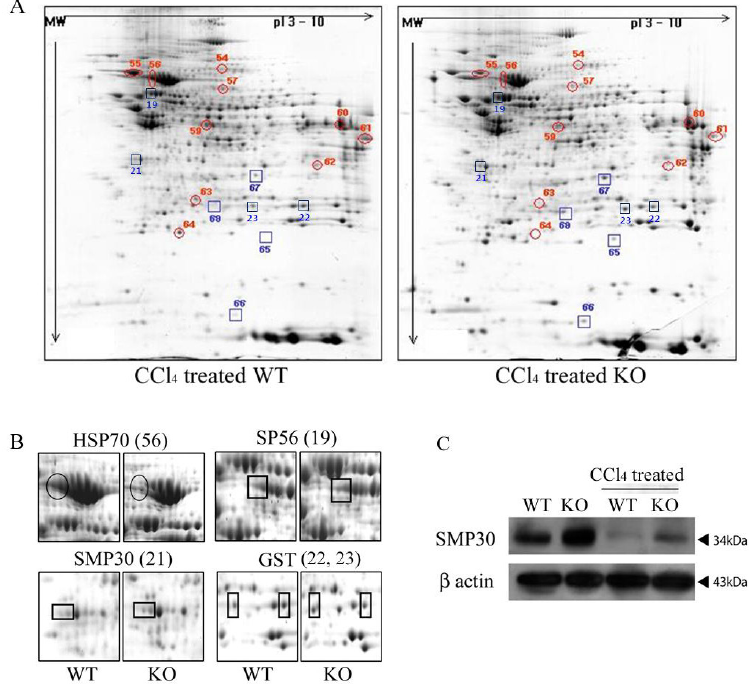
Figure 3. Substantial differentiated spots in liver tissues of Smad3 −/− mice. ( A ) Gel images of two dimensional gel electrophoresis (2-DE). Protein from liver tissue of Smad3 +/+ and Smad3 −/− mice treated with CCl was separated on a pH 3–10 IPG strip in the first 4 dimension and on an SDS-PAGE (12%) gel in the second dimension; ( B ) Clearly visible spots of the four proteins HSP70, SMP30 , SP56 and GST are reproduced from gel images (SDS-PAGE) on a zoom-in view. WT: Smad3 +/+ mice treated with CCl KO: Smad3 −/− mice treated with CCl ; and ( C ) Immunoblot analysis for SMP30 and 4 β -actin (as an internal standard).